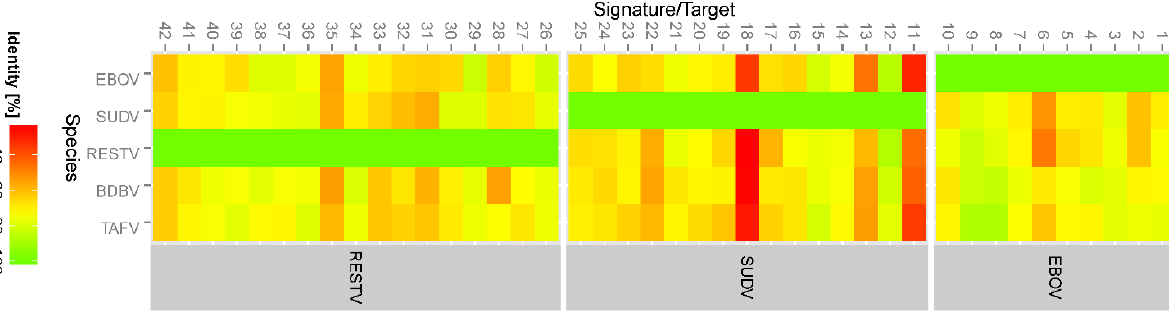
Figure 5. Heat map of percentage identity of Bio Velocity signature hits in various ebolaviruses. The numbers on the x -axis represent species-specific signature IDs (EBOV: 1–10; SUDV: 11–25; RESTV: 26–41). The number of hits for each species for any given signature is given in Table S5. As expected the species-specific signatures are highly conserved in their respective species (indicated by green) compared to other species. The heat index on the left shows the percentage identity.